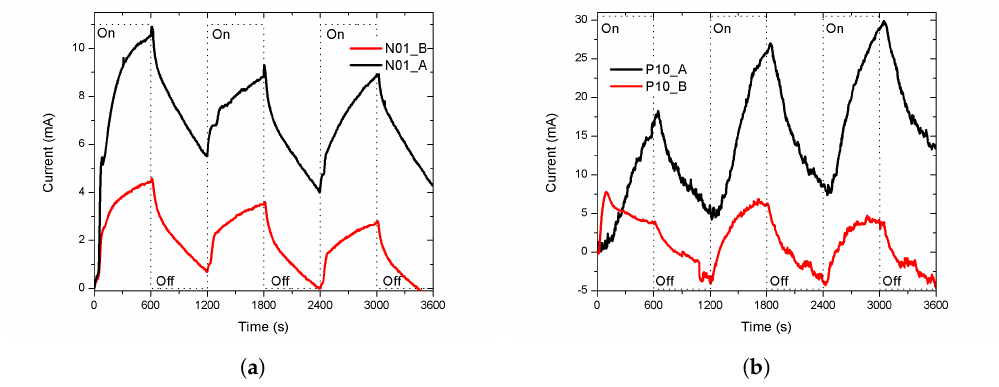
Figure 6. The sensitivity of the response at a lower vapour pressure (11.76 mmHg). The temperature of the chamber remained at 27 ◦ C ( a ) Porous sensor N01. The response of the sensor at 58.73 mmHg, labeled as N01_A, had a similar shape than its response at 11.76 mmHg, labeled as N01_B, but was less intense. ( b ) Porous sensor P01. The first cycle (first 20 min) of the response of the sensor at 58.73 mmHg, labeled as P10_A, was different than its response at 11.76 mmHg, labeled as P10_B, and less intense. The current, in the cycles, was under 0 mA because the baseline was subtracted from the original response so that the intensity of the responses started at zero and can be compared.